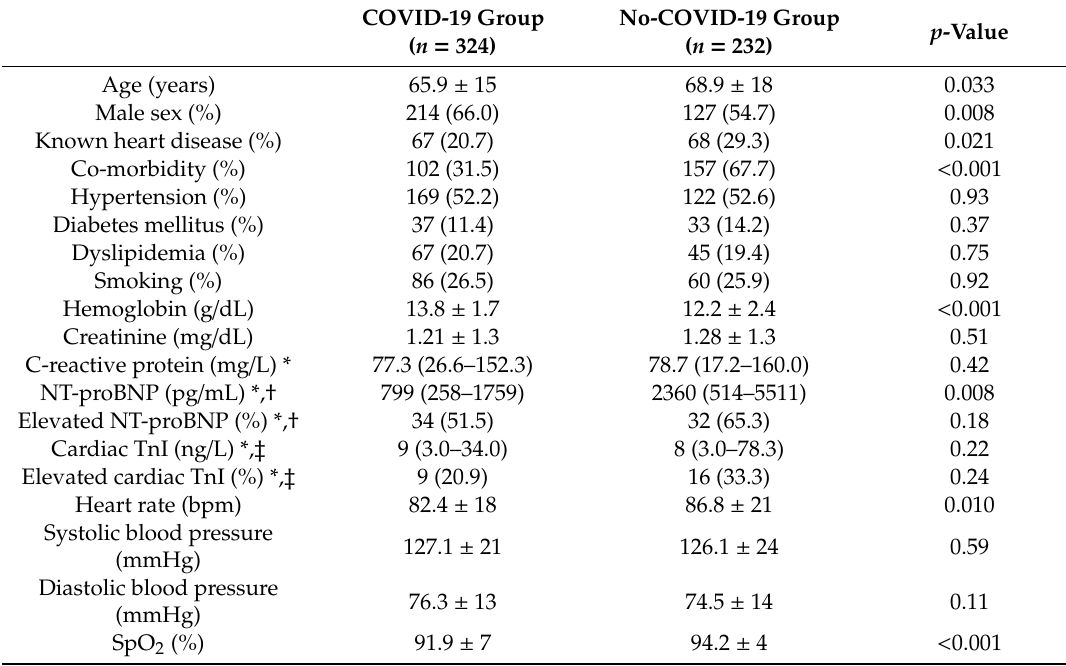
Table 1. Main clinical characteristics of the 2 groups of